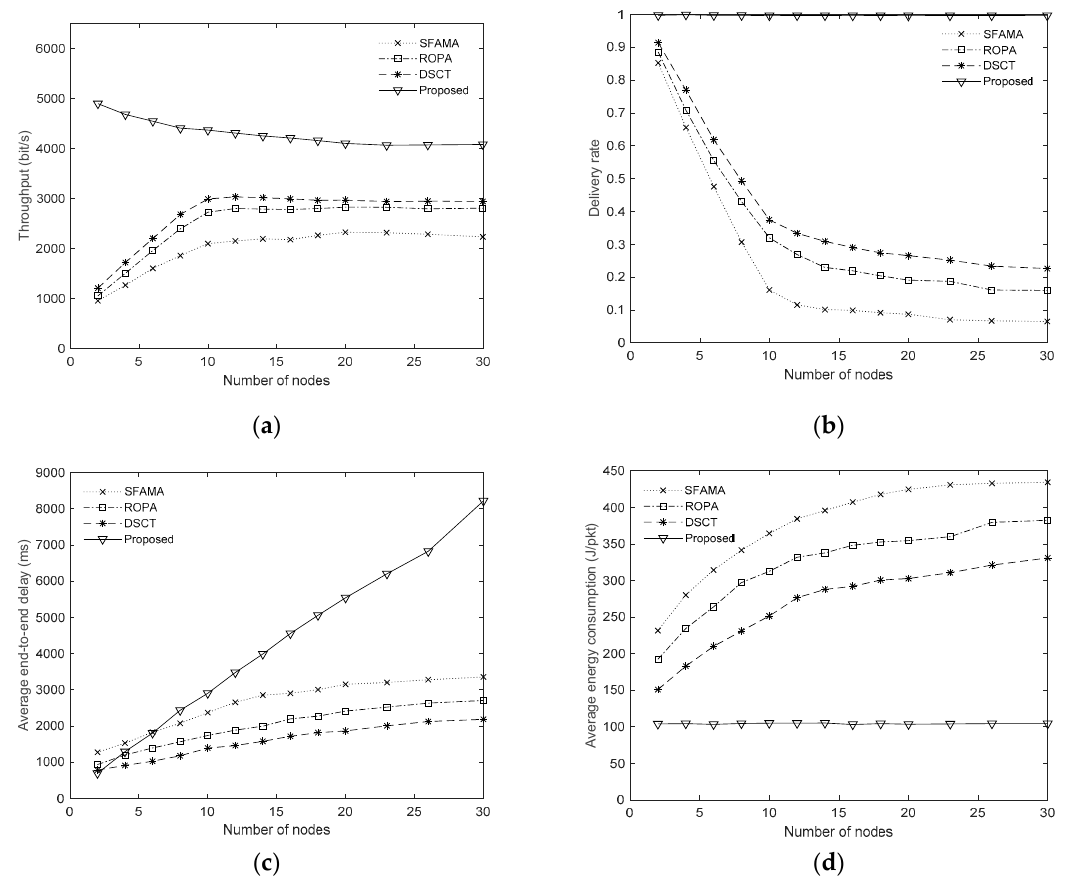
Figure 9. Performance of the SFAMA, ROPA, and DSCT protocols and that of the proposed method under different network sizes. ( a ) throughput; ( b ) packet delivery rate; ( c ) average end-to-end delay; and ( d ) average energy consumption.